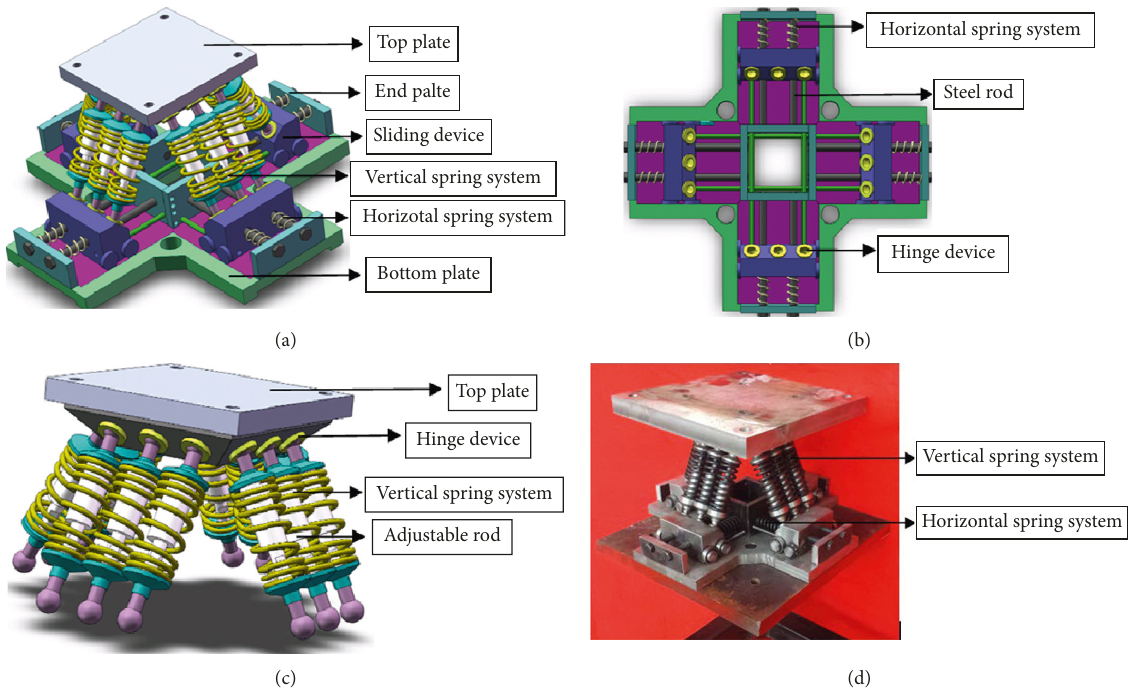
Figure 4: Details of the three-dimensional mechanical isolation device. (a) Isometric drawing of the support; (b) top view of horizontal isolation; (c) isometric drawing of vertical isolation; (d) the support used in the